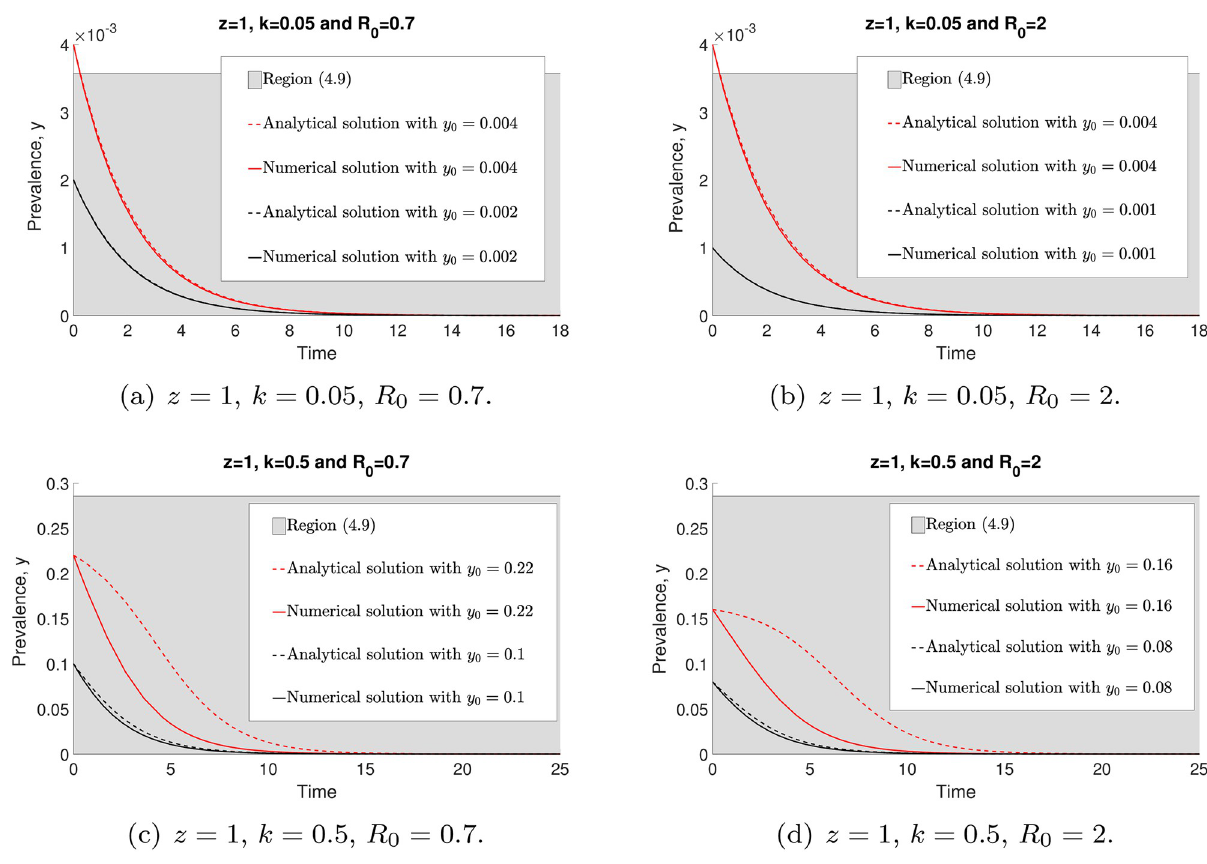
Fig 14. The comparisons of analytical (21) and numerical (18) solutions with arbitrary k , R 0 and initial values around y = 0. Both analytical and numerical solutions are eventually converging to zero.